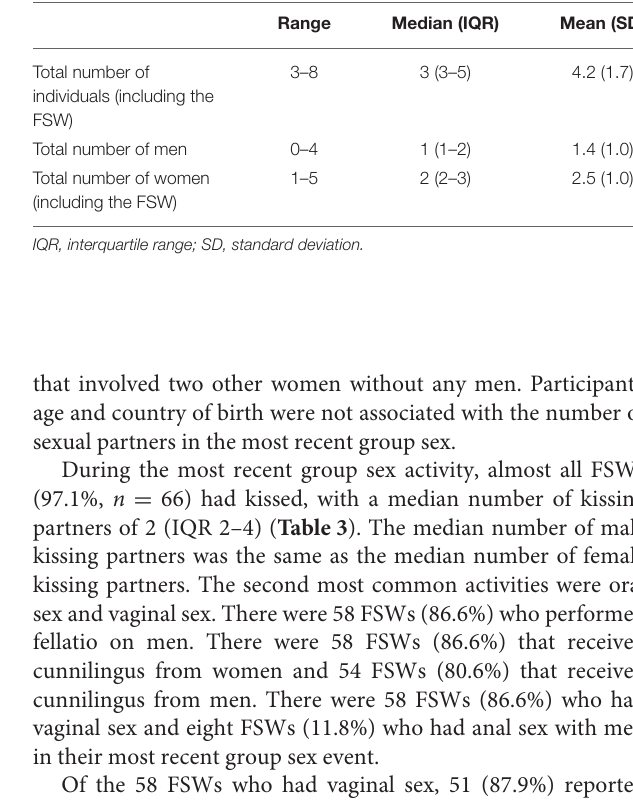
TABLE 2 | Total number of individuals participating in the most recent group sex event among 68 female sex